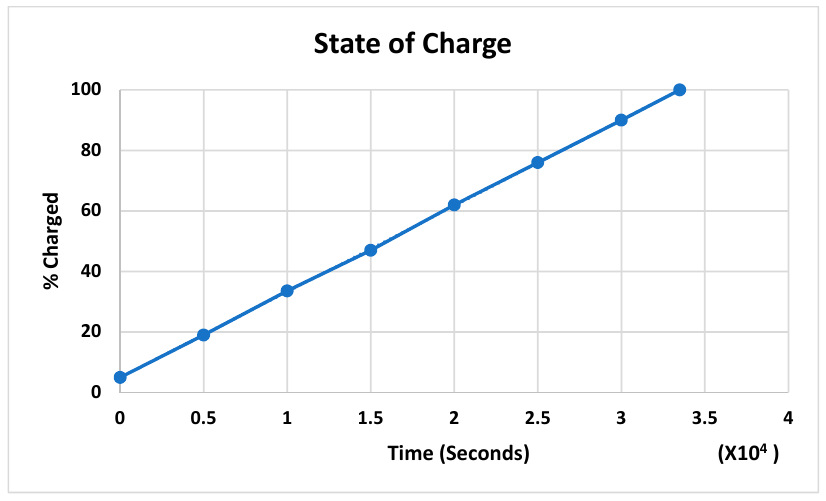
Figure 21. Charging/State of Charge for the Designed Circuit.